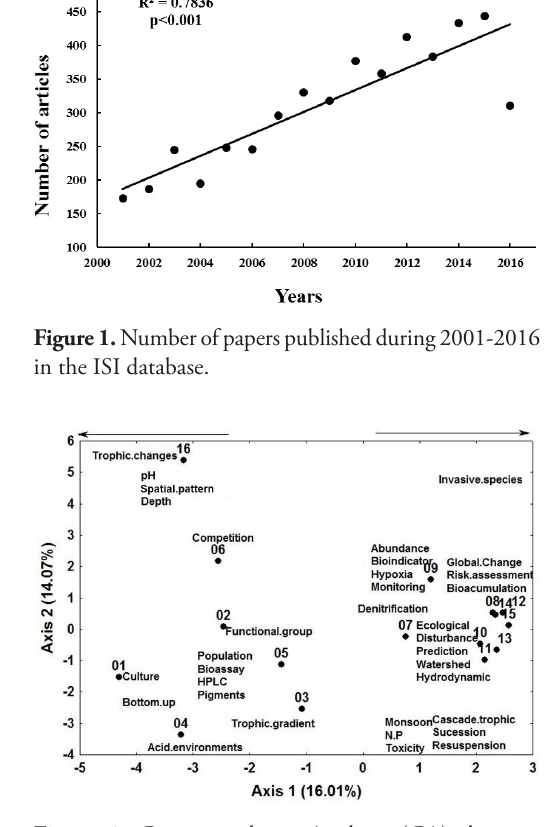
Figure 2. Correspondence Analysis (CA)